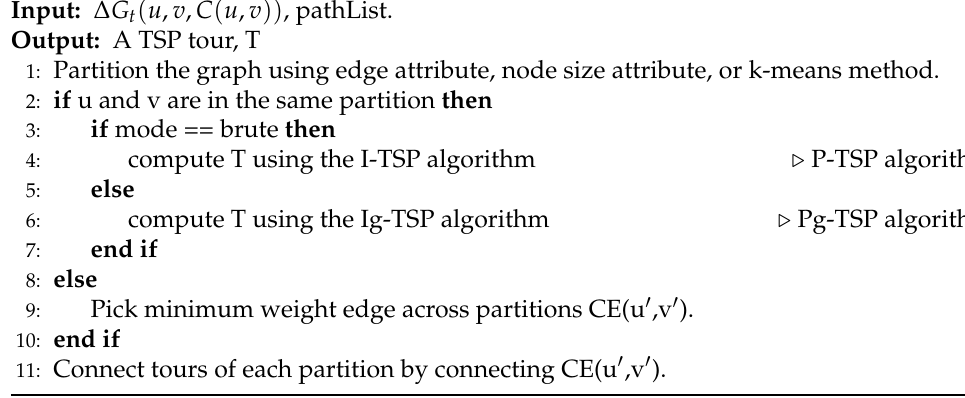
Algorithm 2 Partitioned TSP Algorithms: P-TSP (Based on I-TSP) and Pg-TSP (Based on